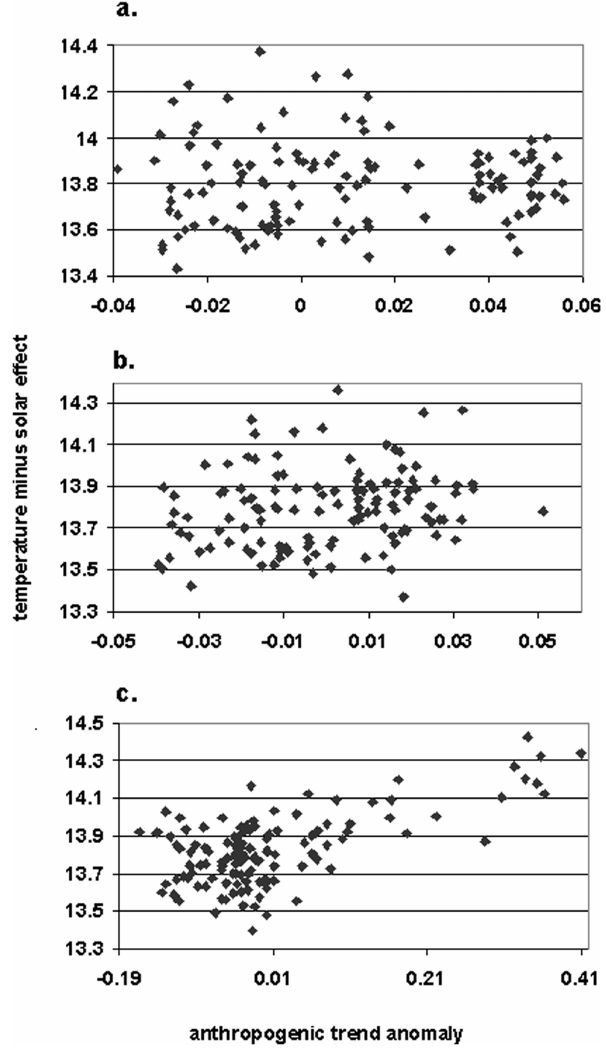
Fig. 3. Statistical association between (scatter plot of) anthro- pogenic anomaly (abscissa), and net temperature effect (i.e. tem- perature minus the estimated solar irradiance effect; ordinates). Pan- els (a) – (c) display the results of the models presented in models 1 and 2 in Table 3 and Eq. (13), respectively. The anthropogenic trend anomaly sums the weighted radiative forcings of the greenhouse gases (CO 2 , CH 4 and N 2 O). The calculation of the net temperature effect (as defined above) change is calculated by subtracting from the observed temperature in a specific year the product of the so- lar irradiance in that year times the coefficient obtained from the regression of the particular model equation: 1.763 in the case of model 1 (a) ; 1.806 in the case of model 2 (b) ; and 1.508 in the case of Eq. (13) (c)